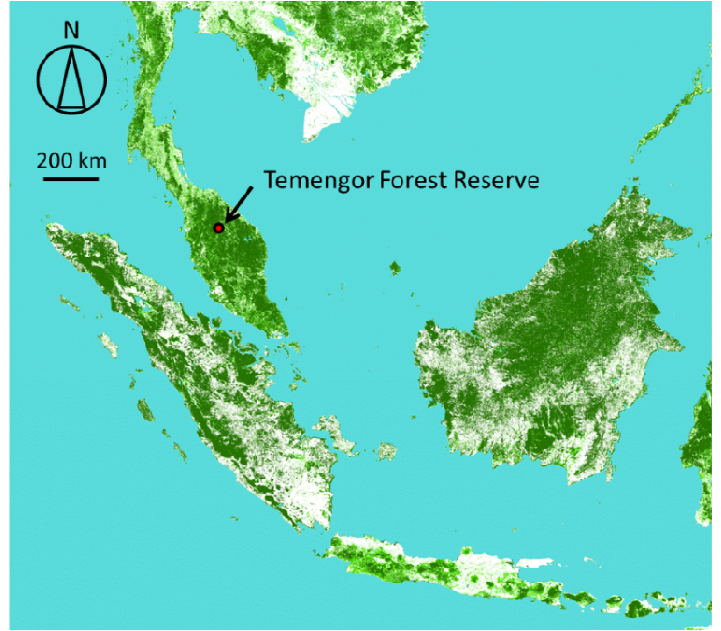
Figure 1. Map showing the location of the study site ( ● ) in the Temengor Forest Reserve in northern Perak State, Malaysia, generated from the Global Map from the Geospatial Information Authority of Japan (GSI). The greener parts have the higher percent of tree covers. Our study site (the Temengor Forest Reserve) is indicated by an